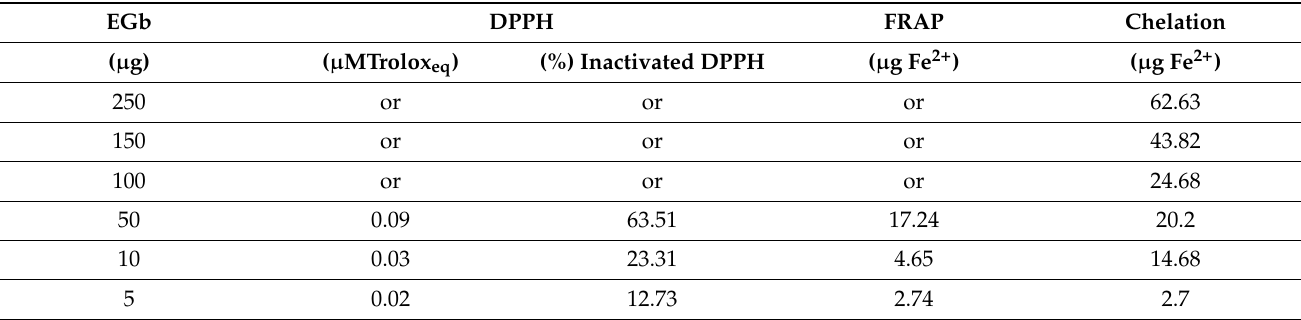
Table 3. Concentration-dependent antioxidant activity (in vitro) of